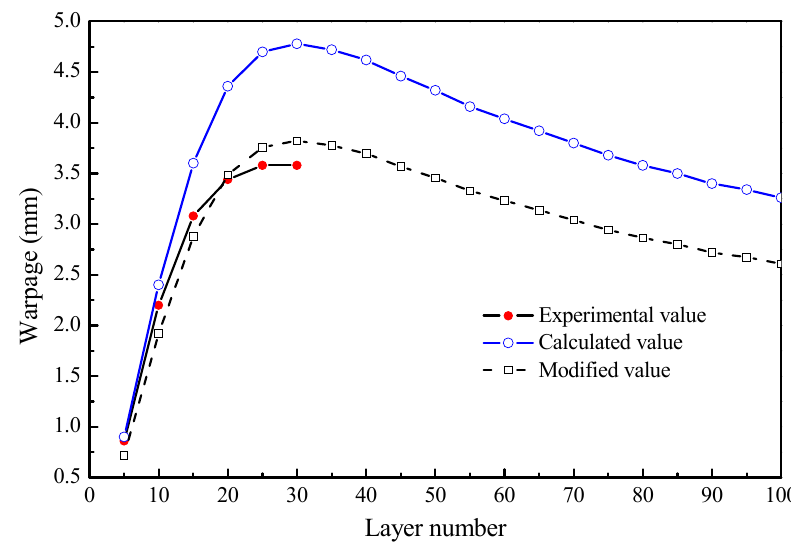
Figure 7. Warpage comparisons between the calculated and experimental value.